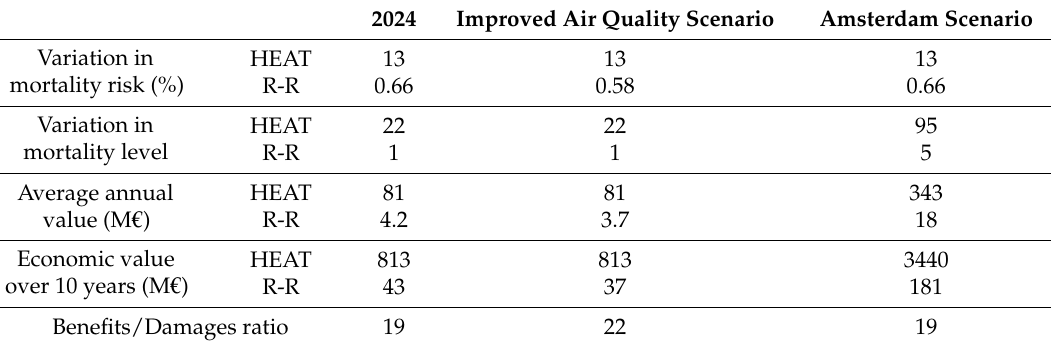
Table 3. Outputs of the HEAT for cycling and the R-R models for different scenarios when trip duration is equal to 30 min/day.